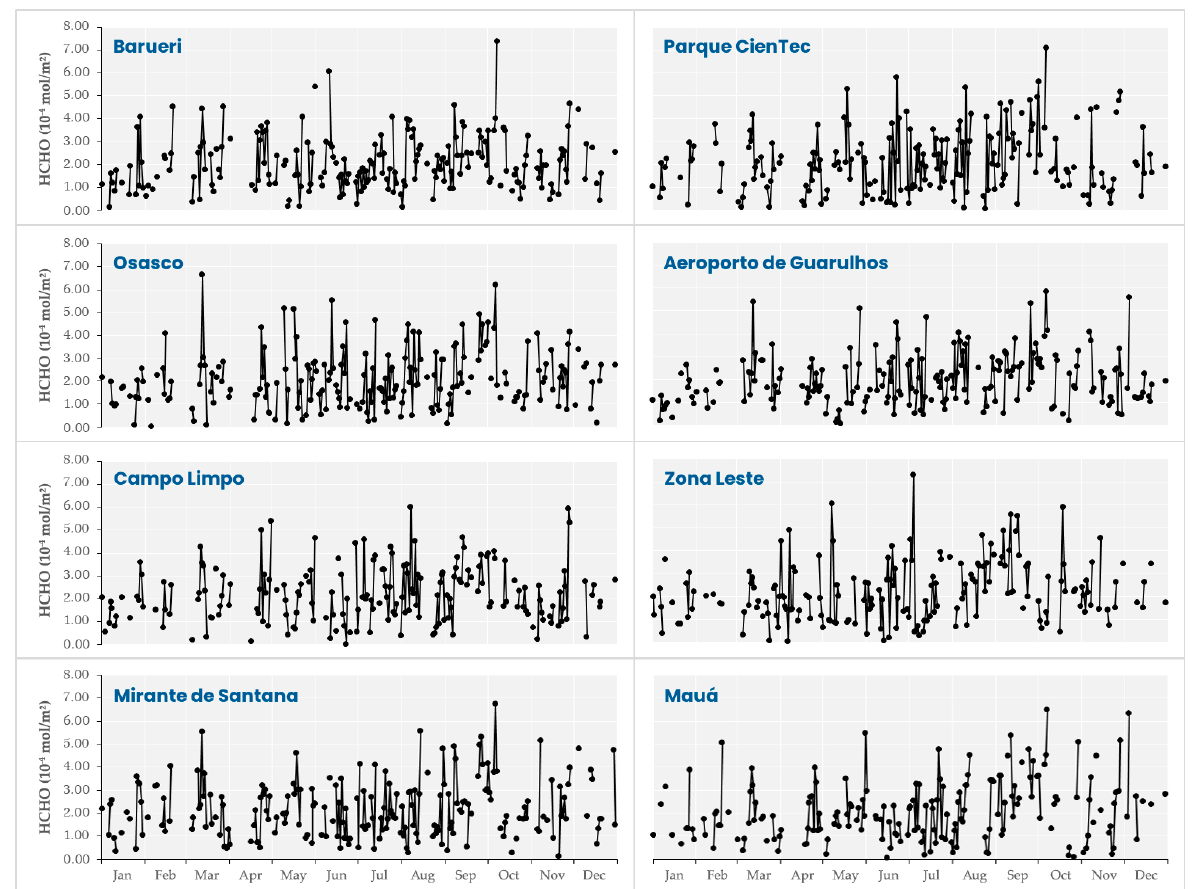
Figure 5. Daily HCHO mean columns (12 p.m.–4 p.m. local time) located in the MASP analysis windows throughout